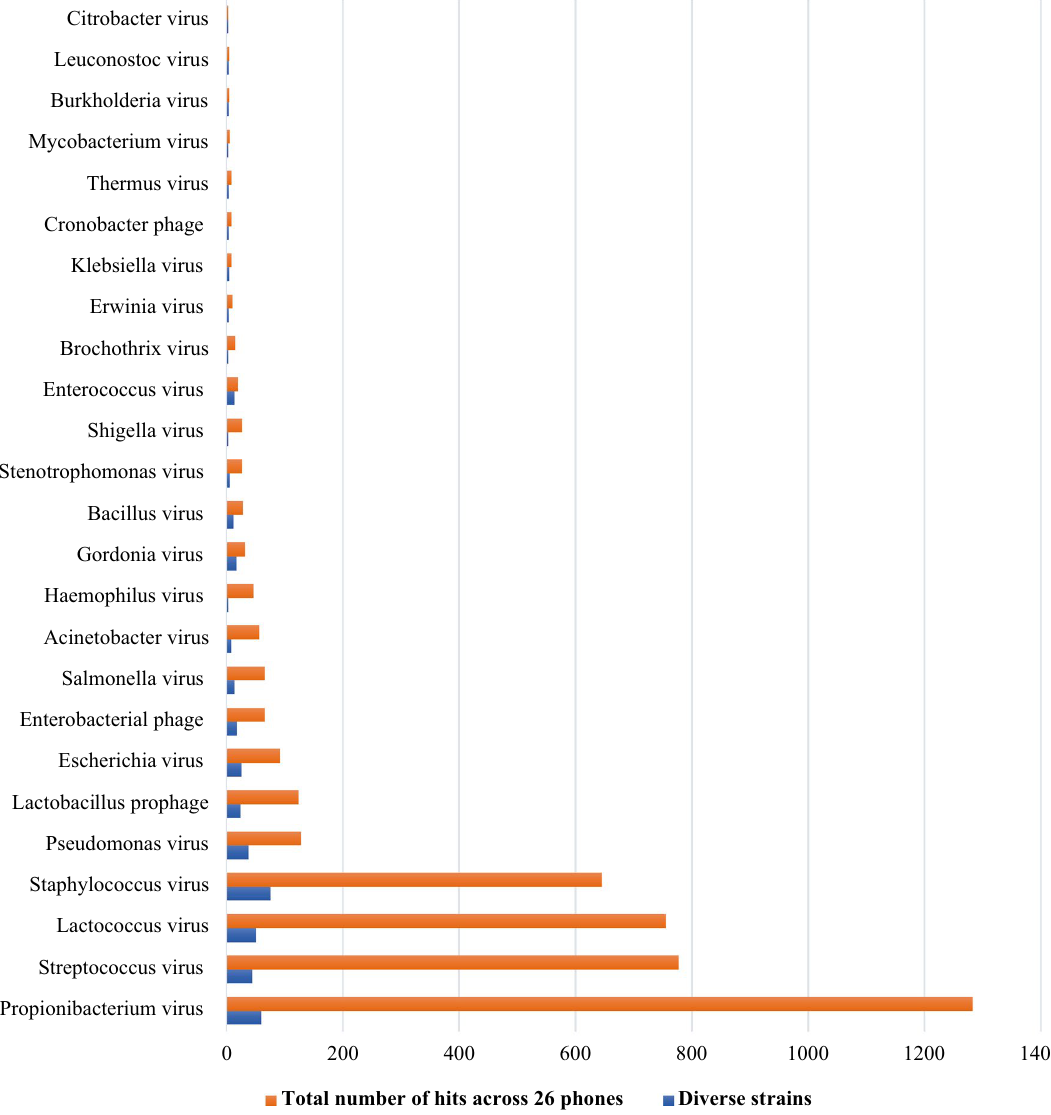
Figure 4. Distribution of bacteriophages identified across the 26 mobile phones.